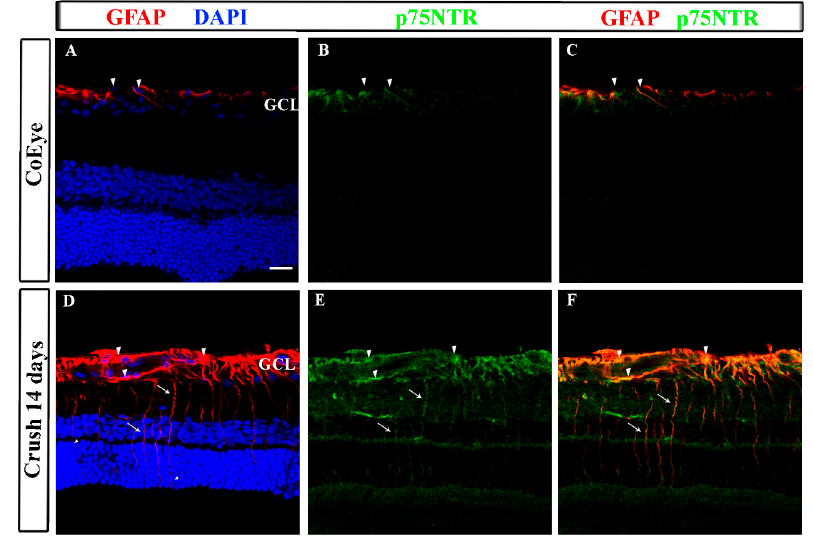
Figure 4. GFAP and p75 NTR expression in the retina 14 days after crush. Retinal sections of CoEye and Crush eyes. In the CoEye retinas, GFAP and p75 NTR are expressed only in the cells of the GCL ( A , B ). In the Crush retinas, astrocytes in the GCL and Müller cells (arrows indicate radial processes) up-regulate GFAP ( D ) and p75 NTR ( E ). ( C , F ) GFAP and p75 NTR merges. Arrowheads indicate cells that co-express GFAP and p75 NTR . GCL: ganglion cell layer; scale bar: 20 μ m. CoEye: contralateral eyes.